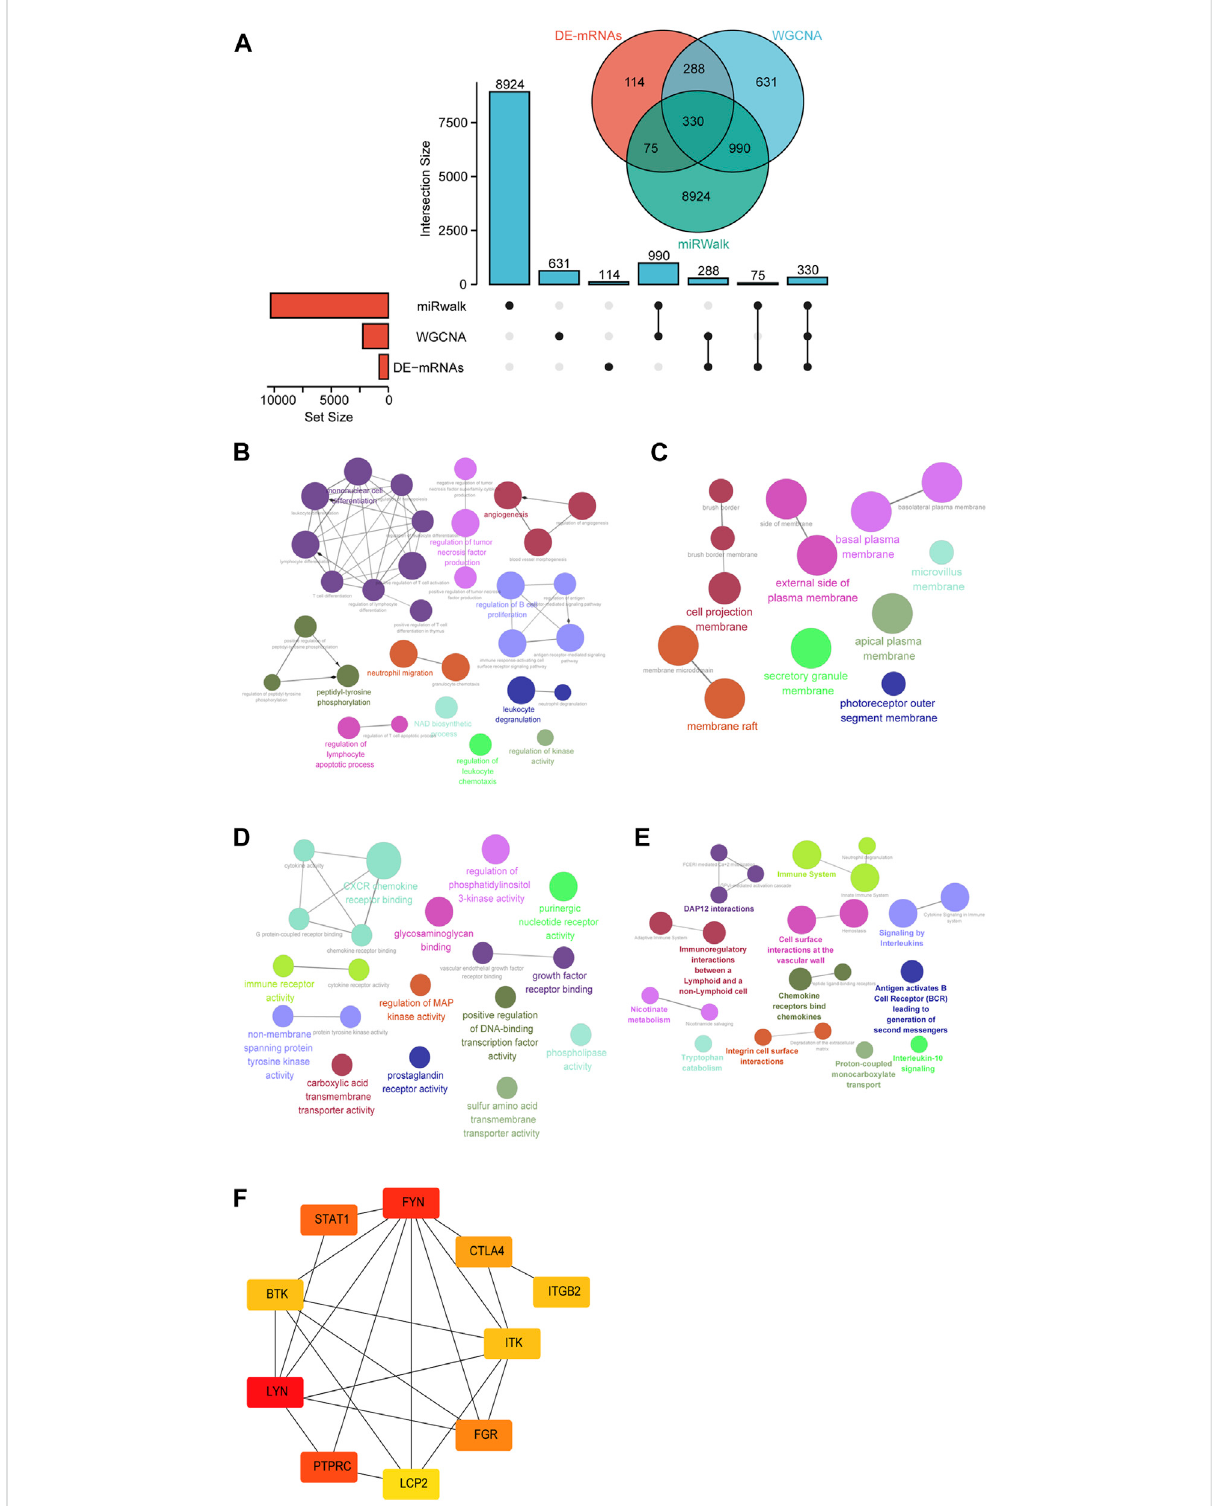
FIGURE 5 Identi fi cation of candidate overlapping mRNA and function annotation. (A) The intersection of DE-mRNAs, WGCNA modules, and miRwalk- predict. (B) BP of overlapping mRNA visualized by ClueGO. (C) CC of overlapping mRNA visualized by ClueGO. (D) MF of overlapping mRNA visualizedbyClueGO. (E) Reactomepathway ofoverlappingmRNAvisualizedbyClueGO. (F) Hubgeneswereidenti fi edintheoverlappingmRNAvia